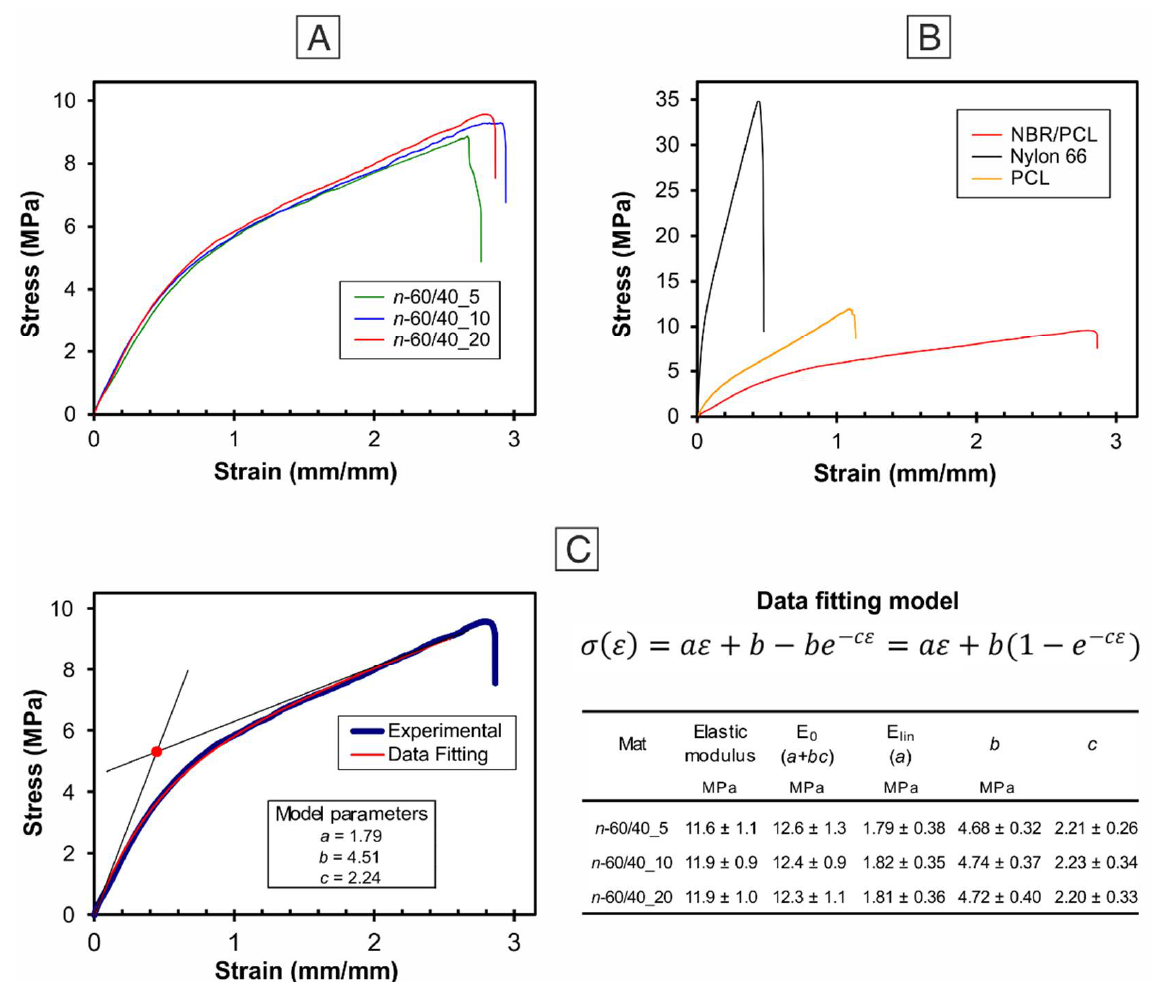
Figure 4. ( A ) Stress-strain curves of n -60/40 nanofibrous mats with different grammage; ( B ) comparison of tensile behaviour of rubbery mat with common thermoplastic ones; ( C ) example of data fitting application and relevant data deriving from stress–strain curve analysis. Stress data were calculated using a reliable mass-based load normalization, according to Equation (1).